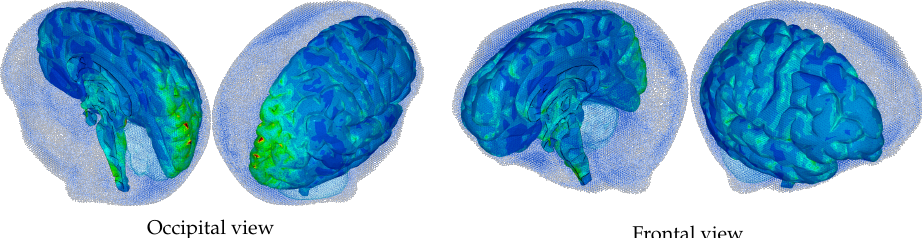
Figure 6. The stress distribution (Scaled; blue: 0, red: max in Wave C) on the brain at the peak of the wave A